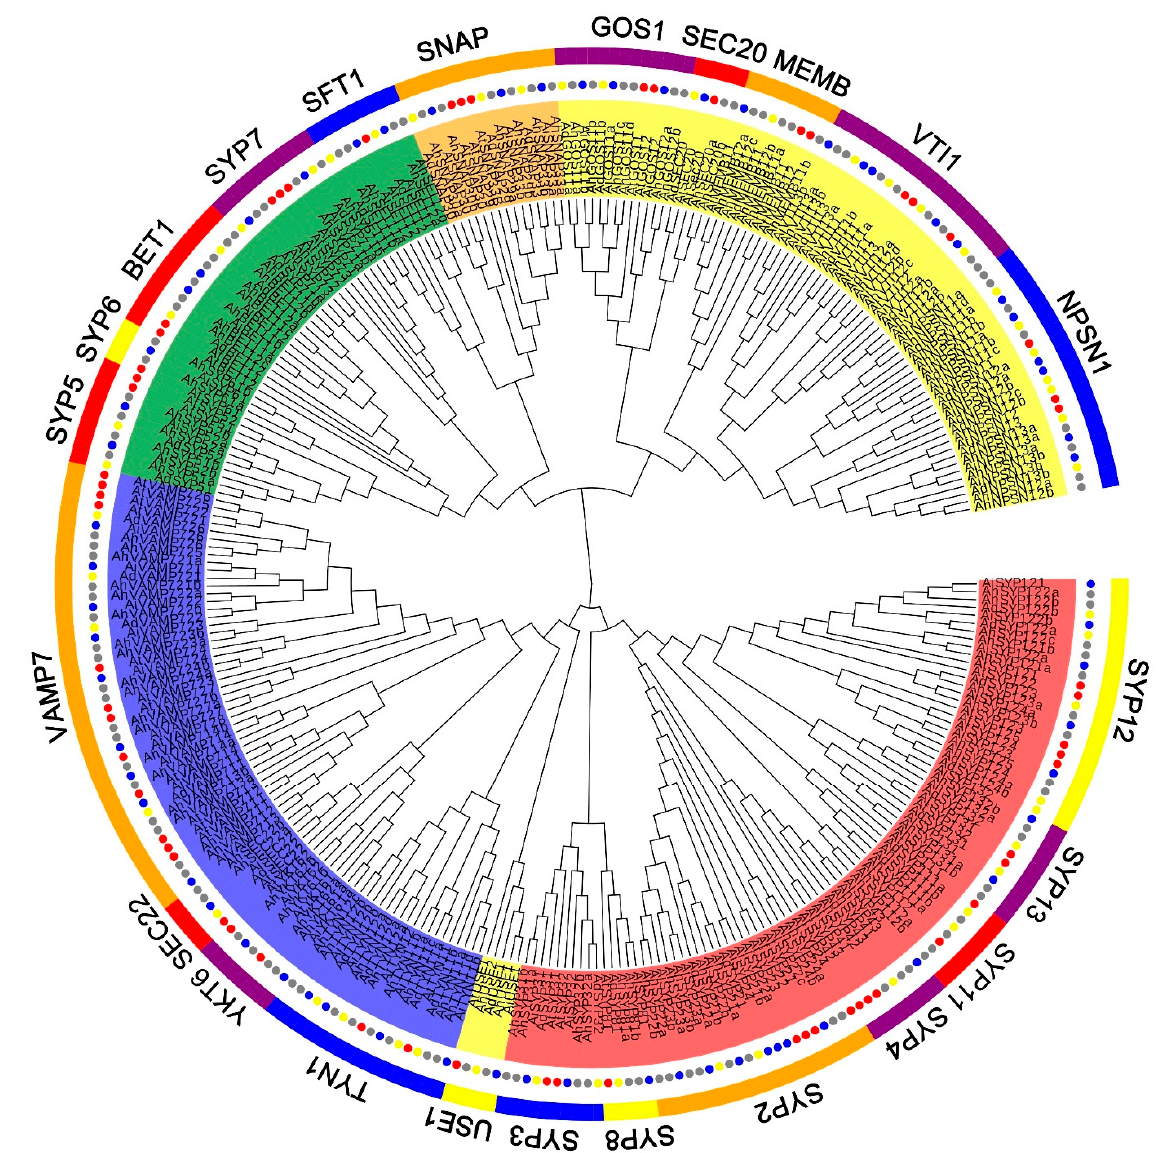
Figure 1. Phylogenetic tree of the SNARE family in A. hypogaea , A. duranensis , A. ipaensis and Arabidopsis . Maximum-likelihood tree based on full-length SNARE proteins sequences reconstructed using the nearest-neighbor-interchange model. SNARE protein sequences from A. hypogaea , A. duranensis , A. ipaensis and Arabidopsis are marked with gray, blue, green and red circles, respectively. Qa-, Qb-, Qc-, Qb+c and R-SNARE are marked with red, yellow, green, orange and blue backgrounds, respectively. The ribbon in the outer ring indicates different subfamilies.